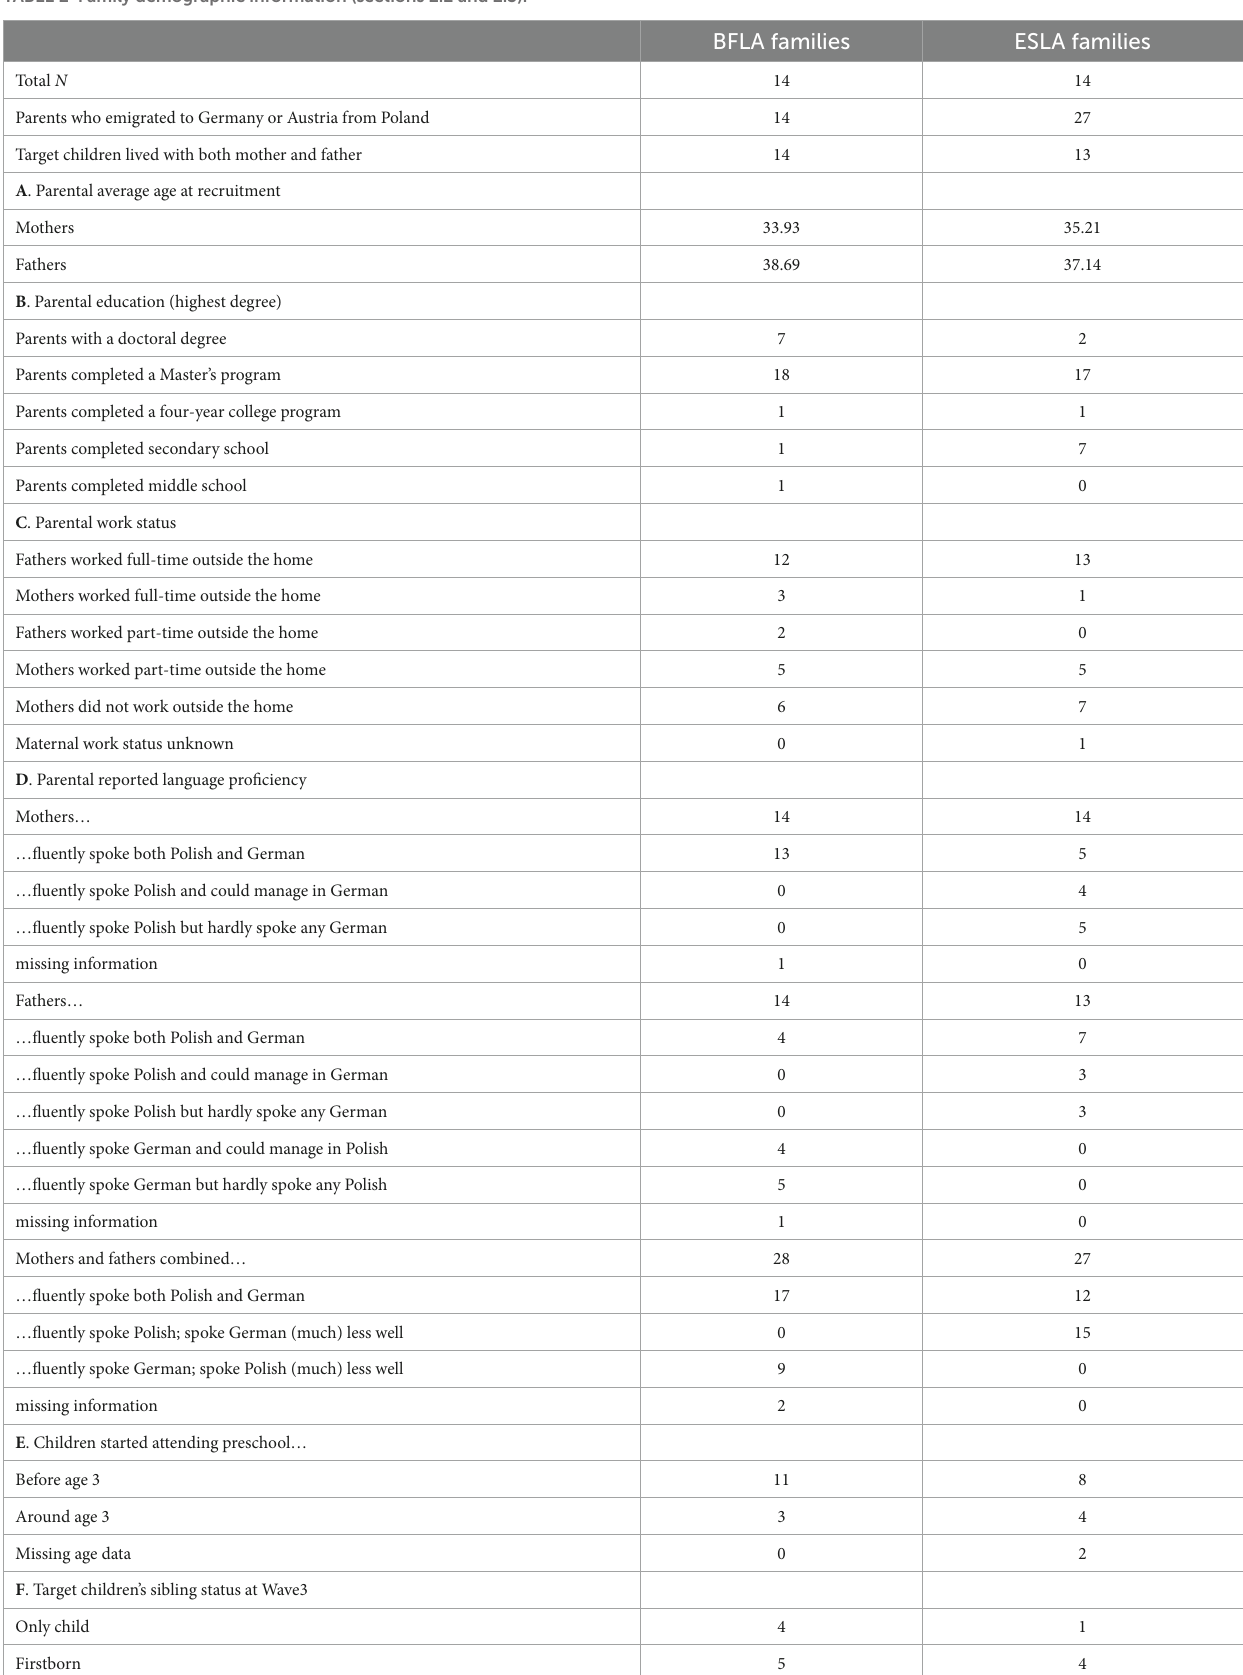
TABLE 2 Family demographic information (sections 2.2 and 2.3).